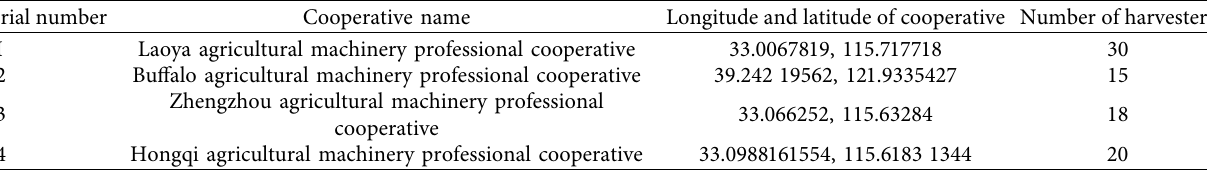
Table 2: Cooperative information